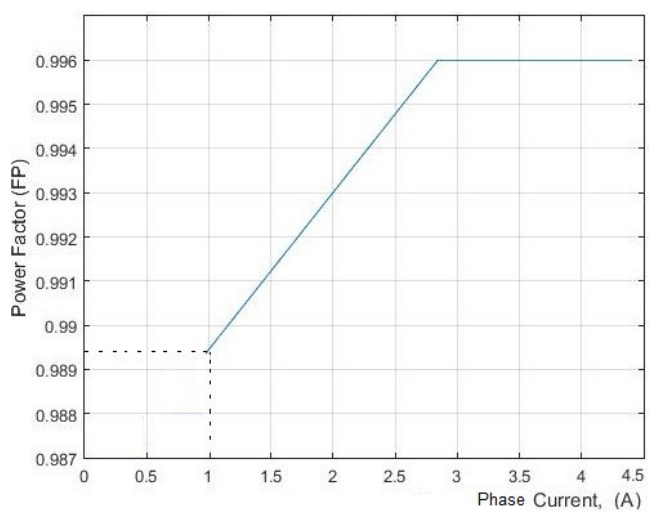
Figure 20. Power factor vs. phase current.